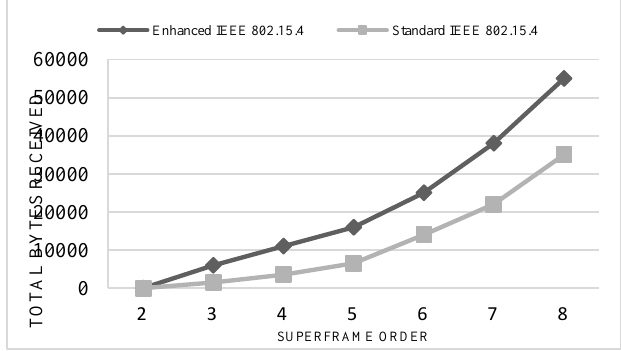
Fig. 5. Comparison between total bytes received resulted from the original and enhanced standard 6.3 Average Packet Delivered by IEEE